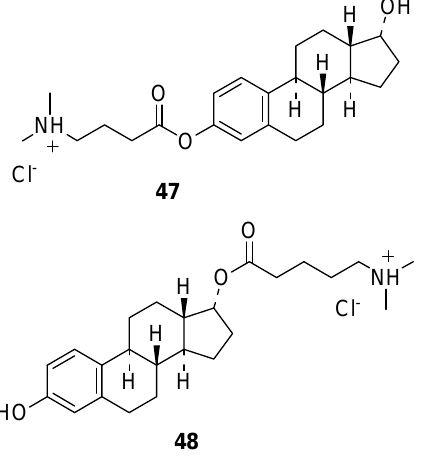
Figure 16. Chemical structures of 17 β -estradiol ester